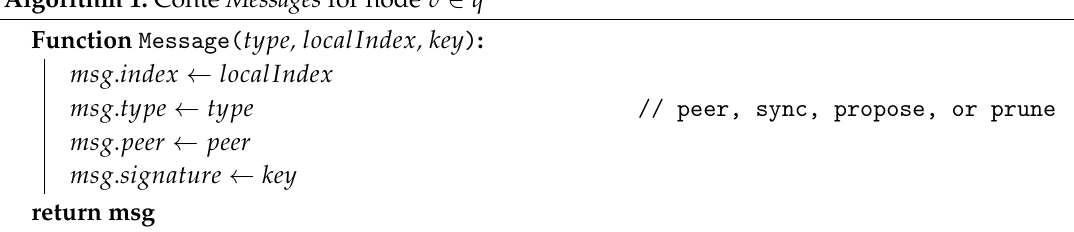
Algorithm 1: Conte Messages for node v ∈